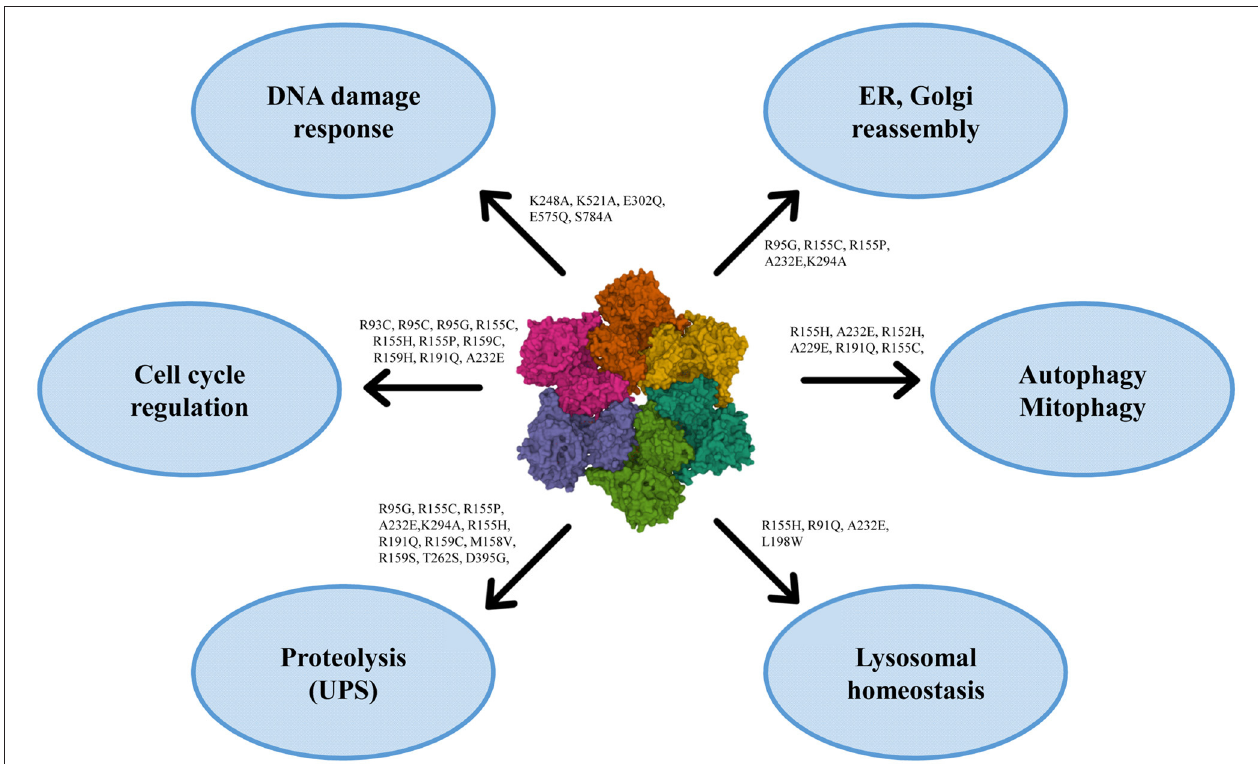
FIGURE 2 | Roles of VCP in the cell with the principal mutations. VCP is involved in ER and Golgi reassembly, autophagy, mitophagy, lysosomal homeostasis, proteolysis, cell cycle regulation and DNA damage response [PDB ID code 3CF3 ( 126)].